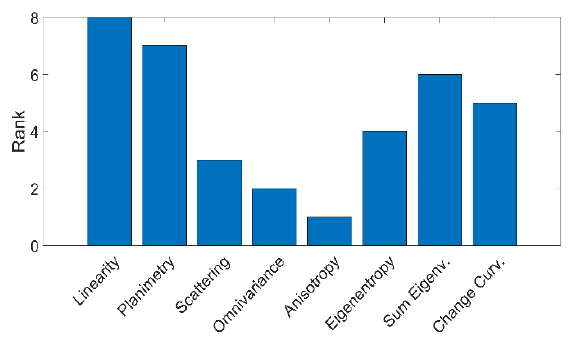
Figure 7. Rank of the eight